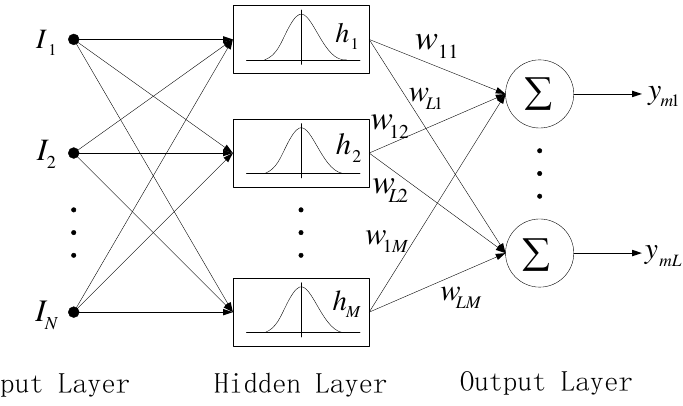
Figure 2. Architecture of a RBF